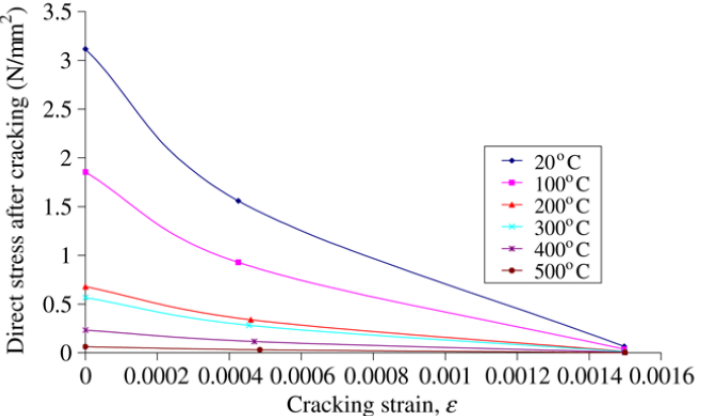
Figure 8. Tensile stress-strain relationship at elevated temperature for concrete, EC2 British Stand- ards Institution.